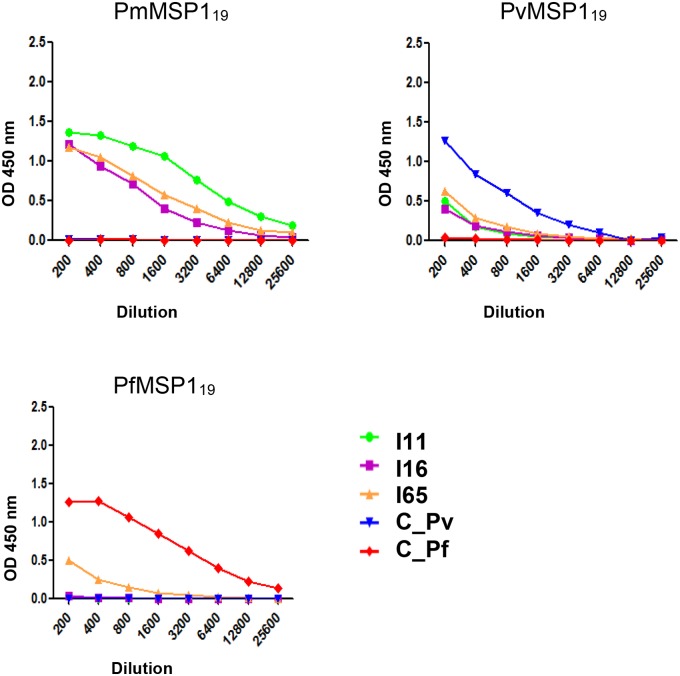
Reactivity by ELISA of recombinant proteins.PmMSP119, PvMSP119 and PfMSP119 proteins, with sera from P. malariae (I11, I16 and I65), P. vivax (C_Pv) or P. falciparum (C_Pf) positive patients.